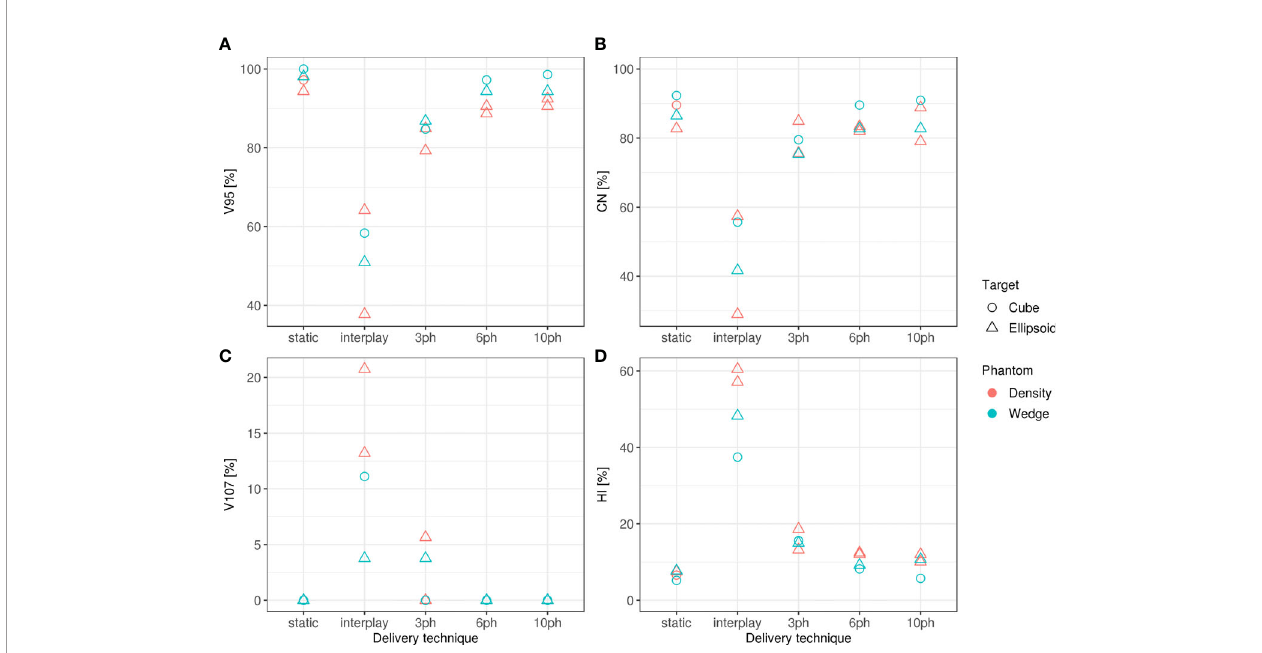
FIGURE 4 | (A) Dose coverage (V 95 ), (B) conformity (CN), (C) overdose (V 107 ), and (D) homogeneity (HI) for static deliveries to stationary targets (static), static deliveries to moving targets (interplay), and 3-phase, 6-phase and 10-phase multi-phase 4D deliveries to cube and ellipsoid target volumes through the wedge and density